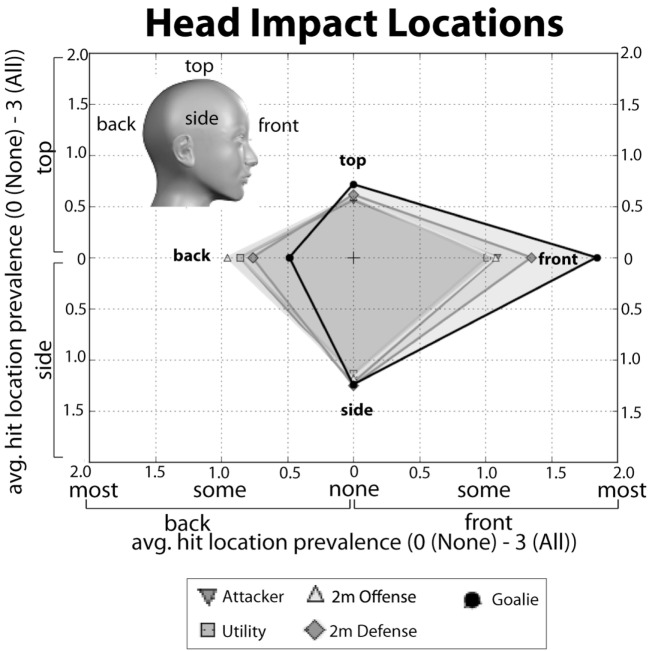
Head impact location “fingerprints” for each position. The average prevalence score (“0-None of the time” to “3-All of the time”) reported for impacts to the back (−x), top (+y), front (+x), or side (−y) of the head. Each score is plotted along the axes given the parentheses above. The fingerprint for each position is the polygon created by connected each impact score for that position along the x and y axes.